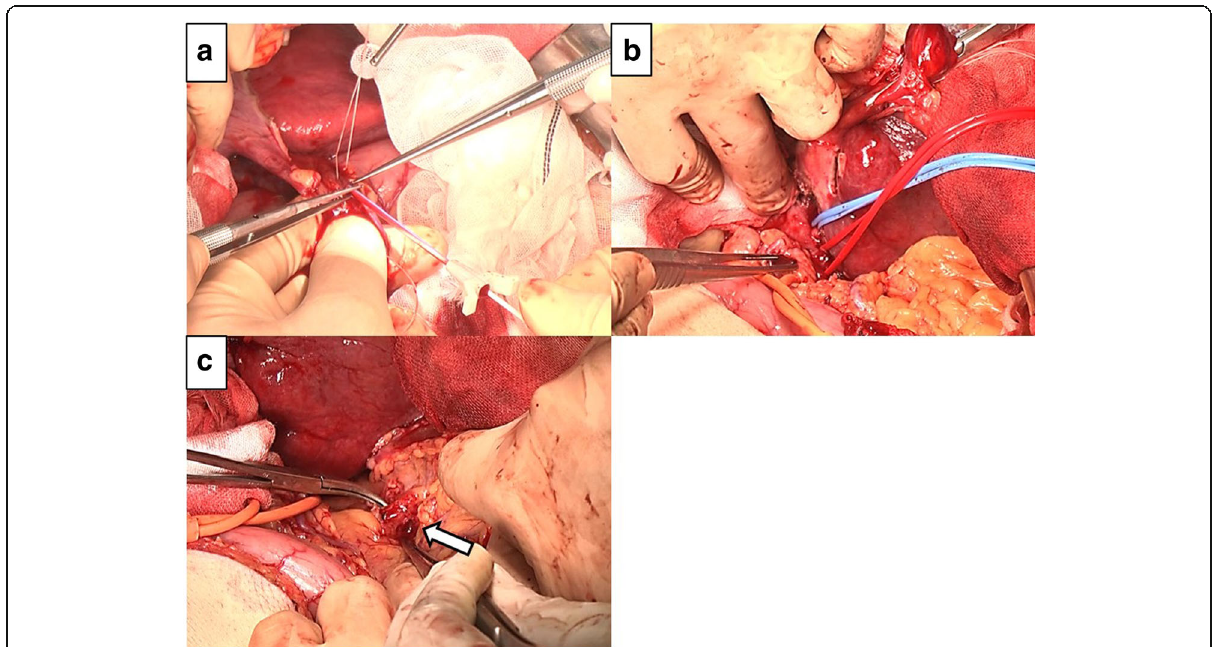
Fig. 4 Intraoperative findings of the primary surgery. a A catheter was inserted from the paraumbilical vein, and the portal venous pressure was measured. b Identification of the left hepatic artery and left branch of the portal vein. c Identification of the left gastric vein (arrow), which supplies the varicose veins